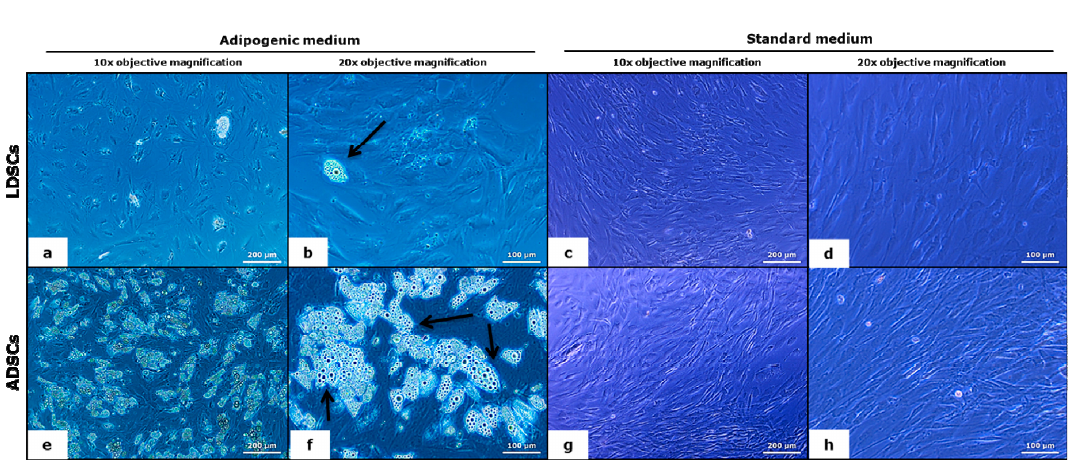
LDSCs in adipogenic medium (AM) ( a , b ), LDSCs in standard medium (DM) ( c , d ), ADSCs in AM